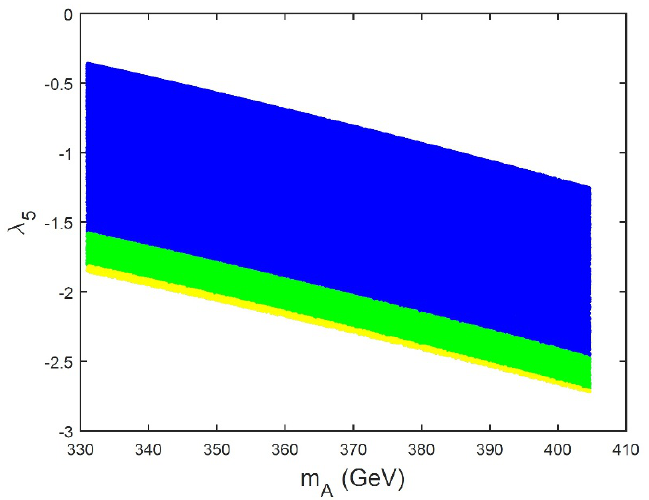
Figure 6 . Scatter plots of (cid:21) 5 vs. m A for the low mass stable benchmark scenario considered. The colour code is the same as in (cid:12)gure